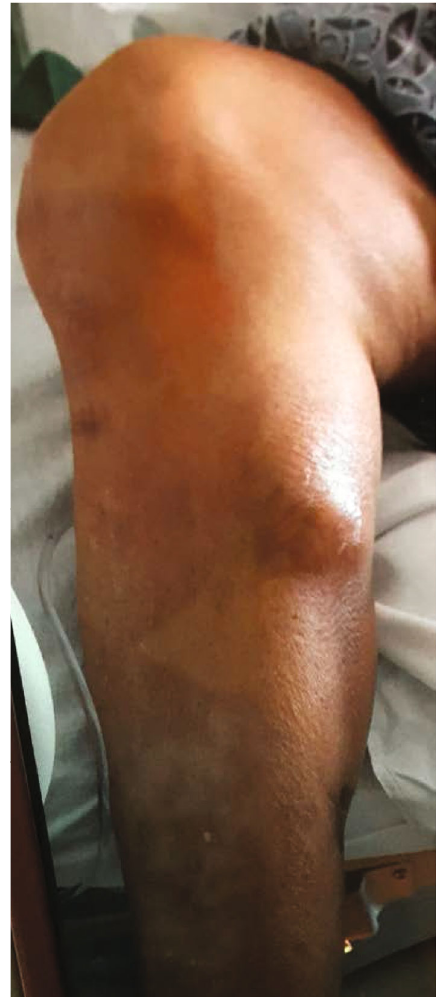
Figure 1: Initial presentation in 2019 — large fl uid collection distal to the right knee on the medial aspect of